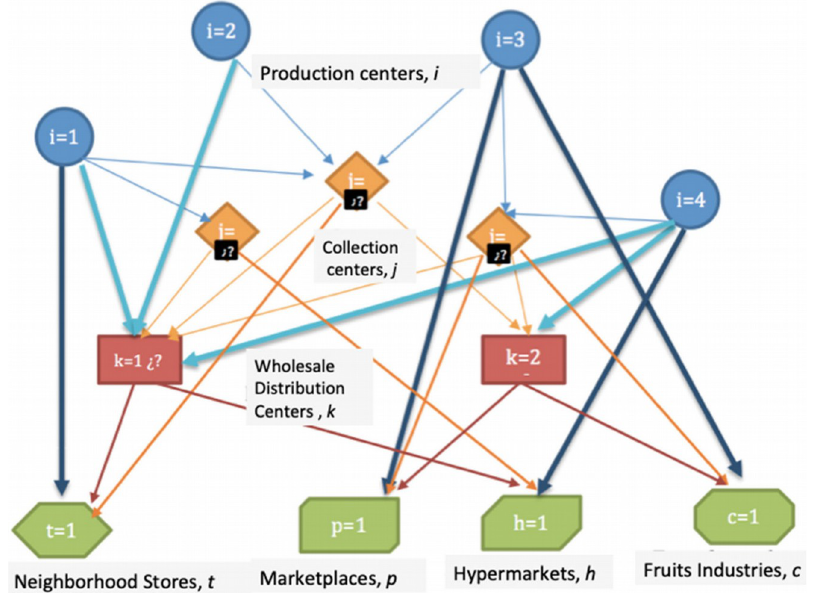
Figure 1. Graph Location